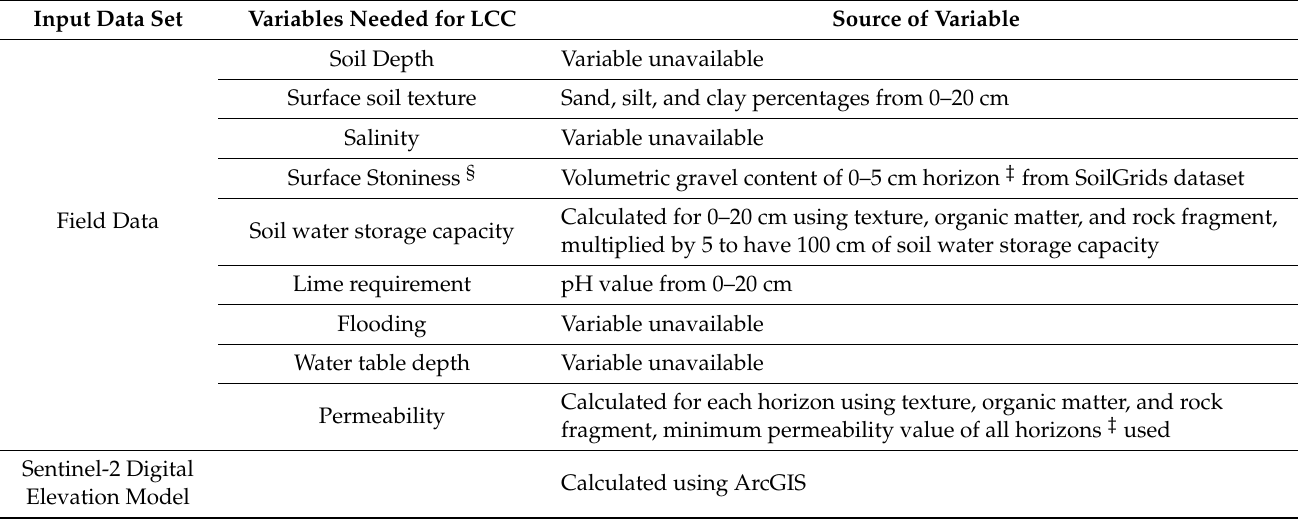
Table 3. LCC calibration—Field Data Source Attributes.